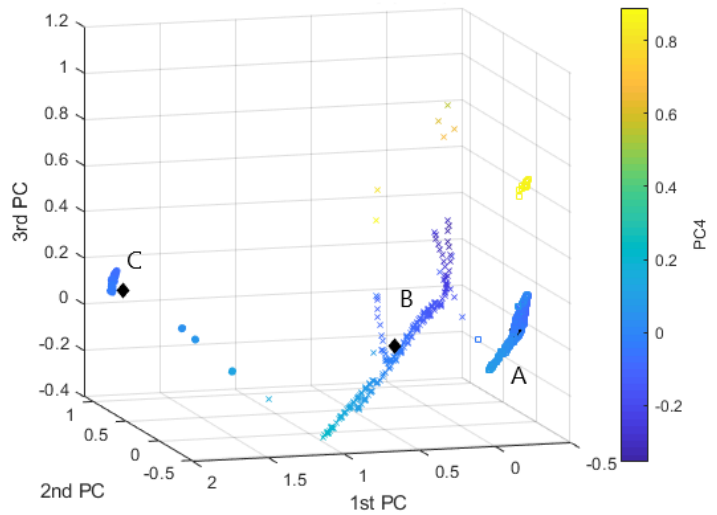
Figure 11. K -means, K = 3. Clustering representation in the principal component scatterplot, Clust.A—“ (cid:3) ”, Clust.B—“ x ”, Clust.C—“ ◦ ”.